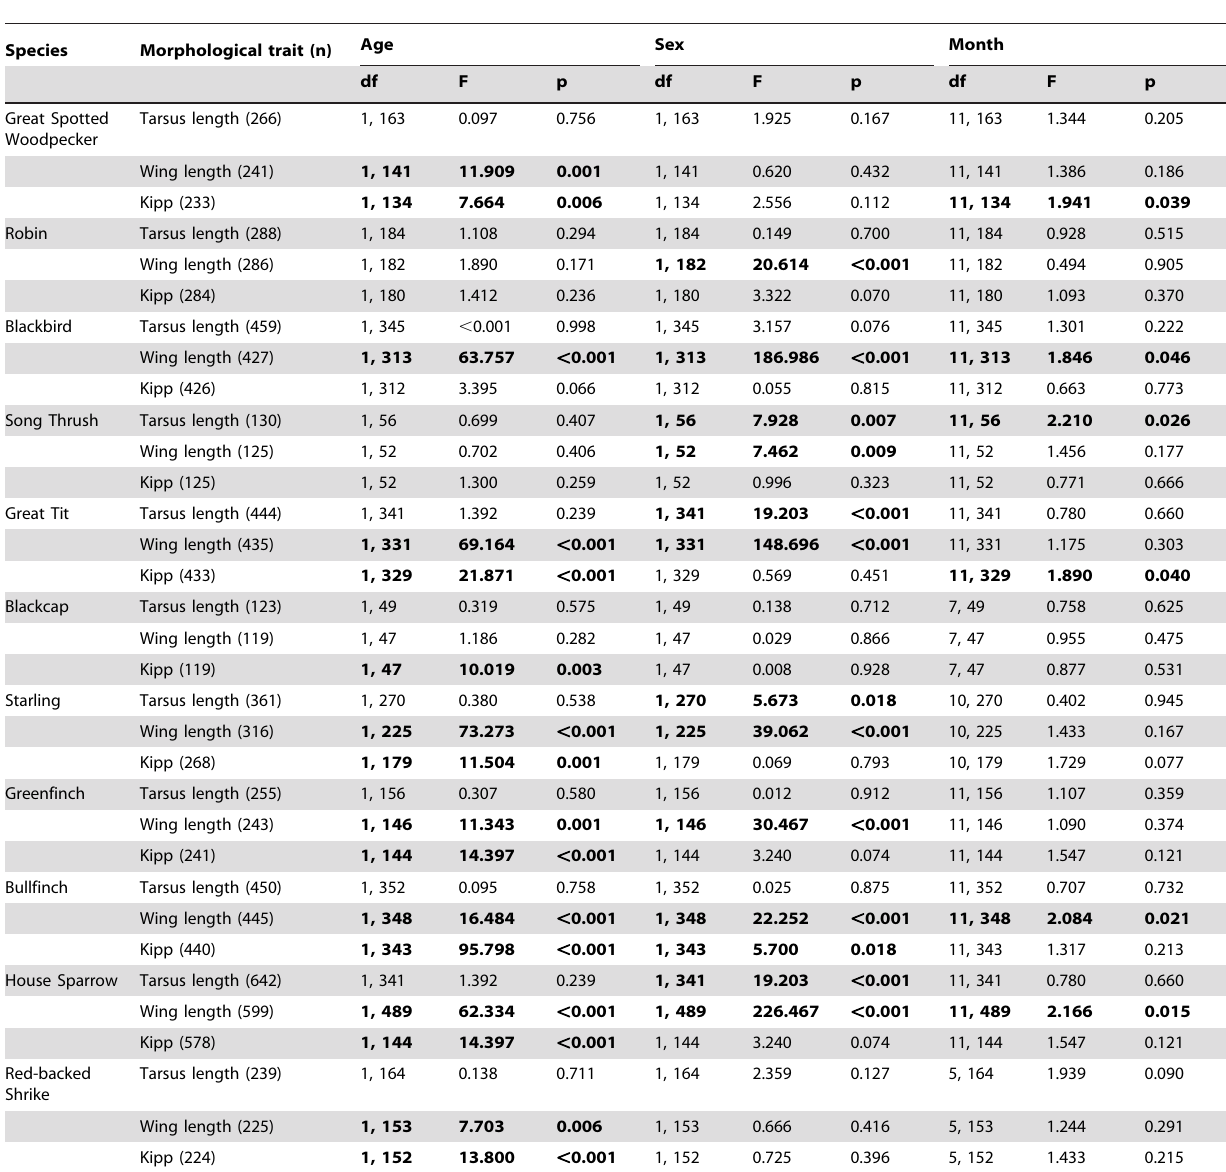
Table 1. Associations of morphological traits with the age, sex and month of collection of specimens in 11 bird species.